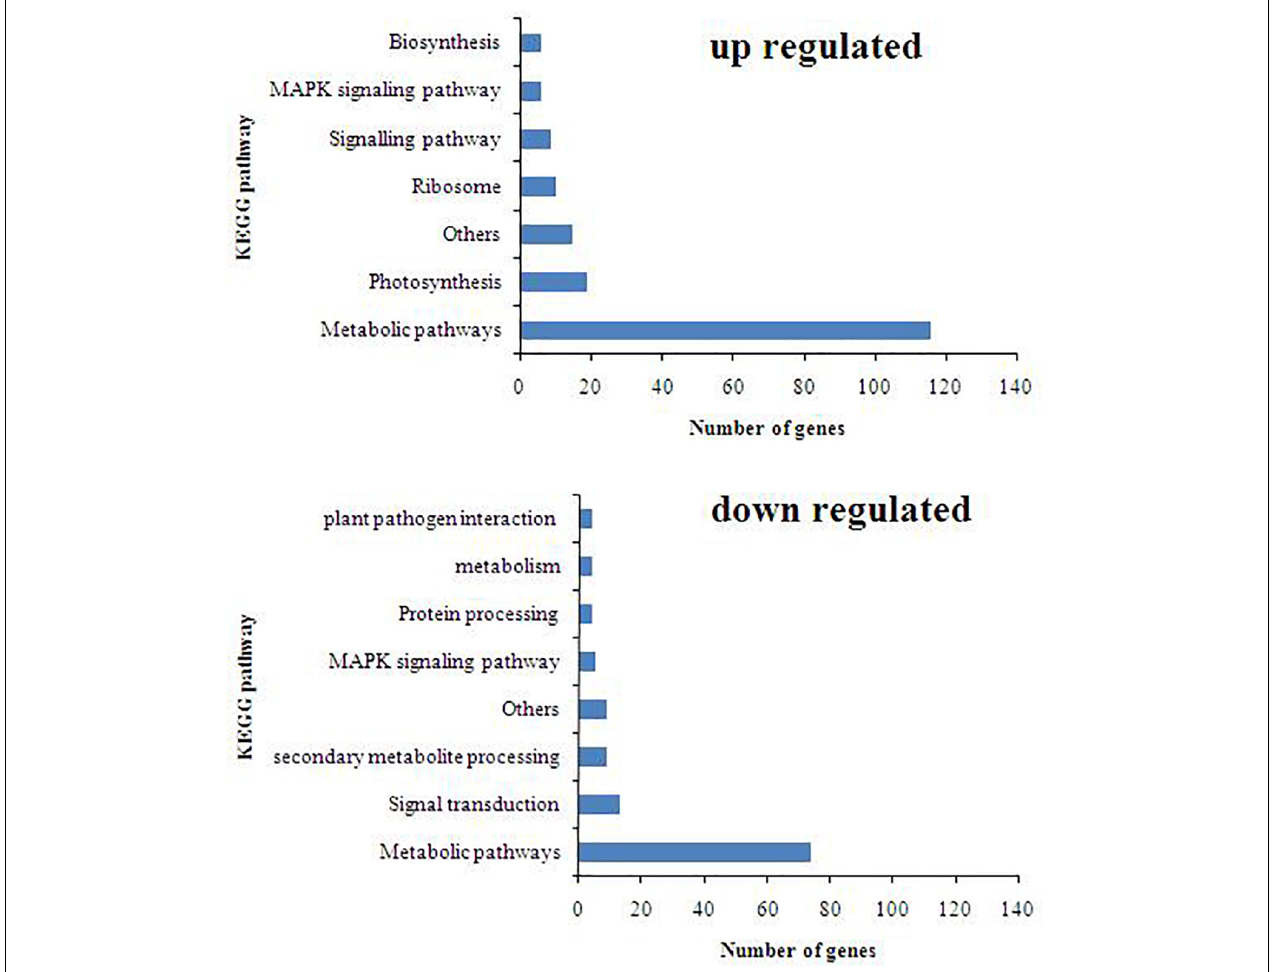
FIGURE 5 | KEGG pathway distribution of upregulated and downregulated